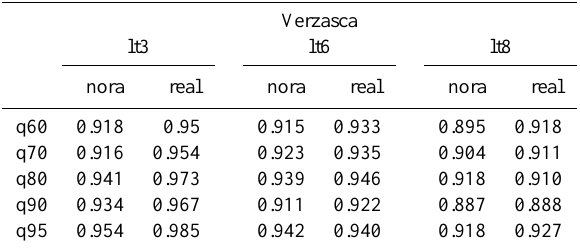
Table 4. ROC area for NORA and REAL-C2 forecasts of the Verza- sca Catchment, with lead times 03:00, 06:00 and 08:00, for the threshold quantiles q60 to q95.